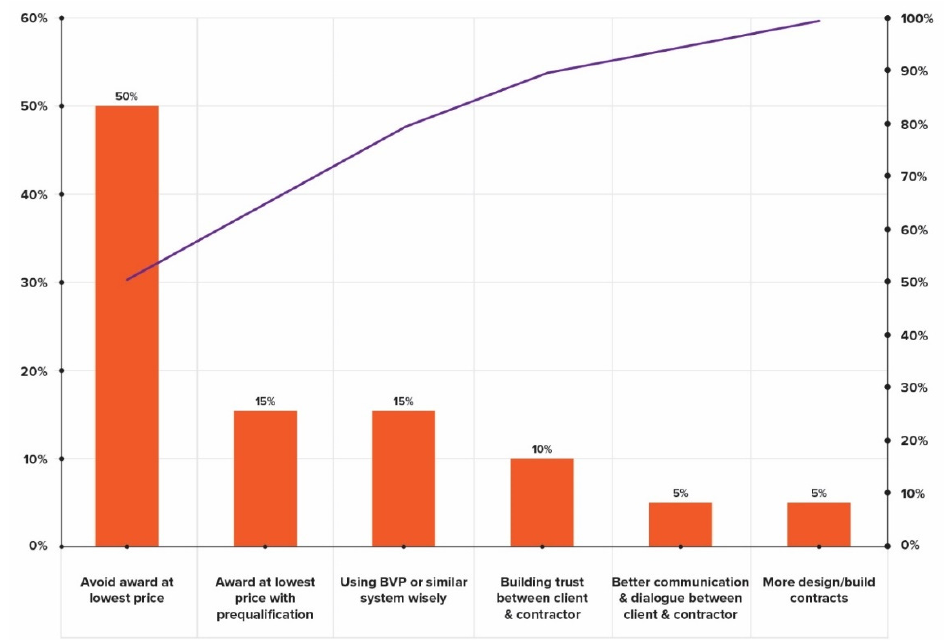
Figure 11. Pareto diagram showing disputes prevention techniques related to low priced contracts.